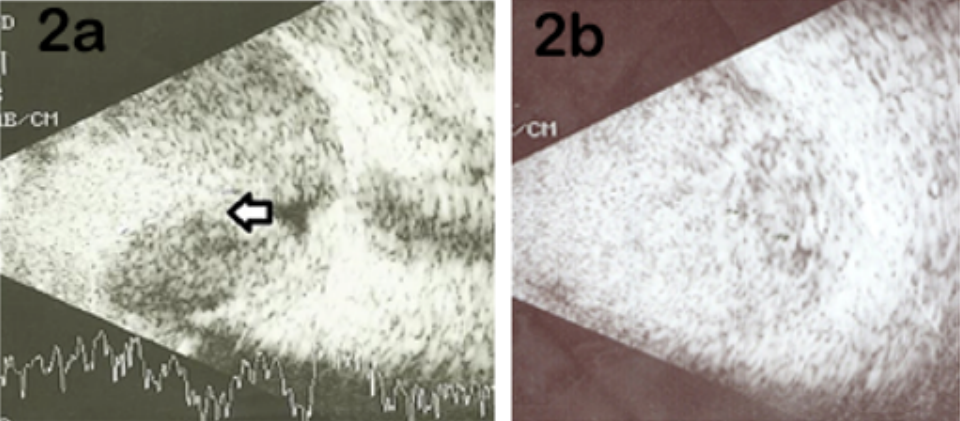
Figure 2: (2a) B scan ultrasonography of case 1 showing annular hemorrhagic CD with “kissing choroids” (arrow); (2b) B scan of case 2 showing findings similar to